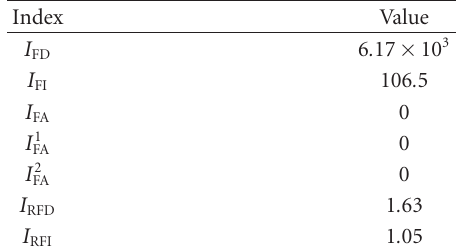
Table 2: FTC performance